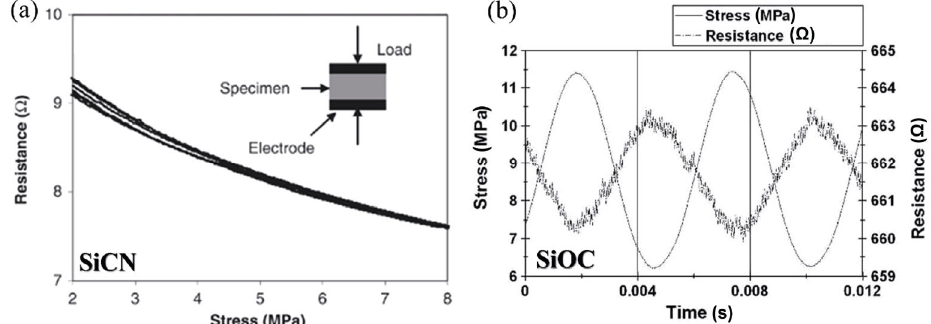
Fig. 13 Experimental proof of the piezoresistive response of (a) SiCN and (b) SiOC. Reproduced with permission from Ref. [101], © The American Ceramic Society 2011; Ref. [357], © The American Ceramic Society 2008.